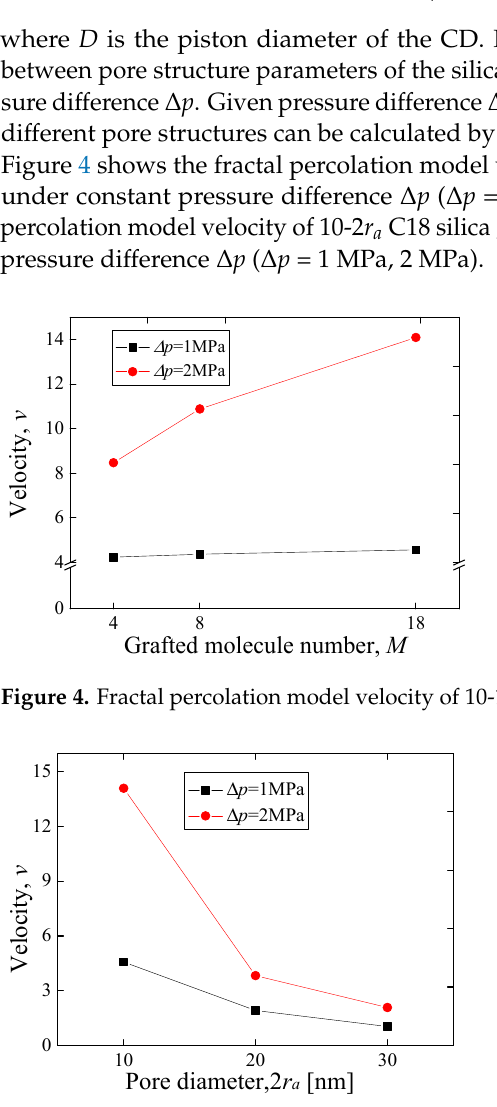
Figure 5. Fractal percolation model velocity of 10-2 r a C18 silica gel.